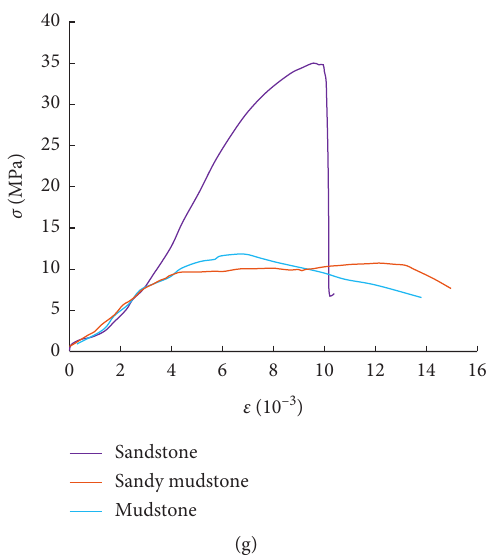
Figure 4: σ - ε relationship diagram of three rock masses at the same temperature. Stress-strain relationship diagram of three kinds of rock masses (a) at 25 ° C, (b) at 30 ° C, (c) at 35 ° C, (d) at 40 ° C, (e) at 45 ° C, (f) at 50 ° C, and (g) at 55 °